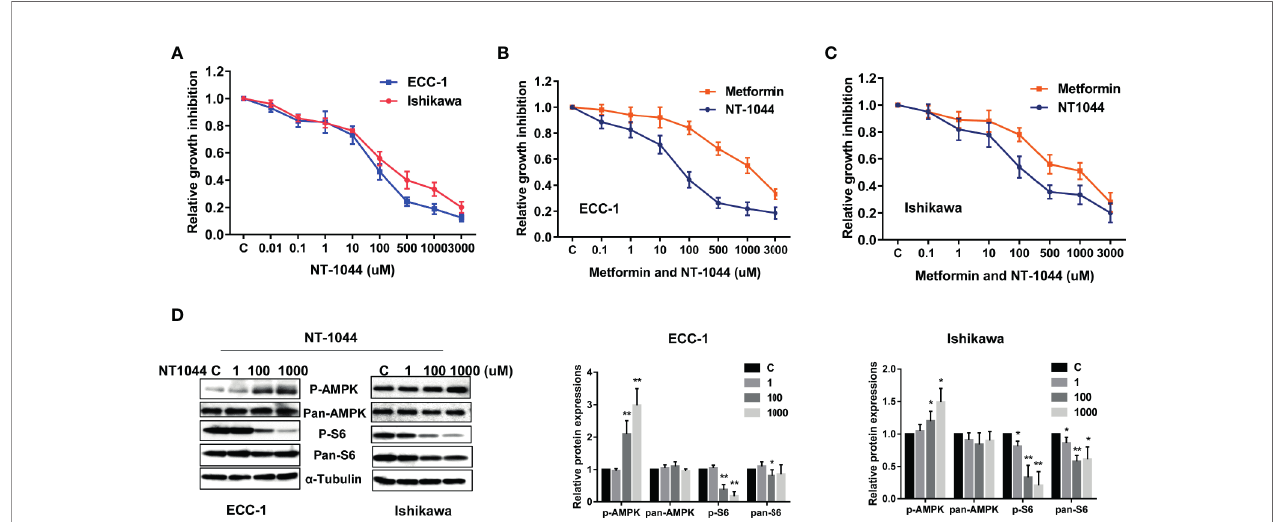
FIGURE 1 | NT-1044 inhibited cell proliferation and activated AMPK pathway in EC cells. The ECC-1 and Ishikawa cells were cultured in regular media for 24 hours, and then treated with the indicated concentrations of NT-1044 and metformin in 96-well plates for 72 hours. Cell proliferation was assessed by MTT assay. NT-1044 and metformin signi fi cant inhibited cell proliferation in a dose dependent manner (A – C) . IC50 value of NT-1044 for ECC-1 = 87 m M; Ishikawa=218 m M. The ECC-1 and Ishikawa cells were treated with NT-1044 for 18 hours. Western blotting showed that NT-1044 increased phosphorylation of AMPK expression and decreased phosphorylation of S6 expression (D) . The results are shown as the mean ± SE of triplicate samples and are representative of three independent experiments. *p < 0.05, **p <